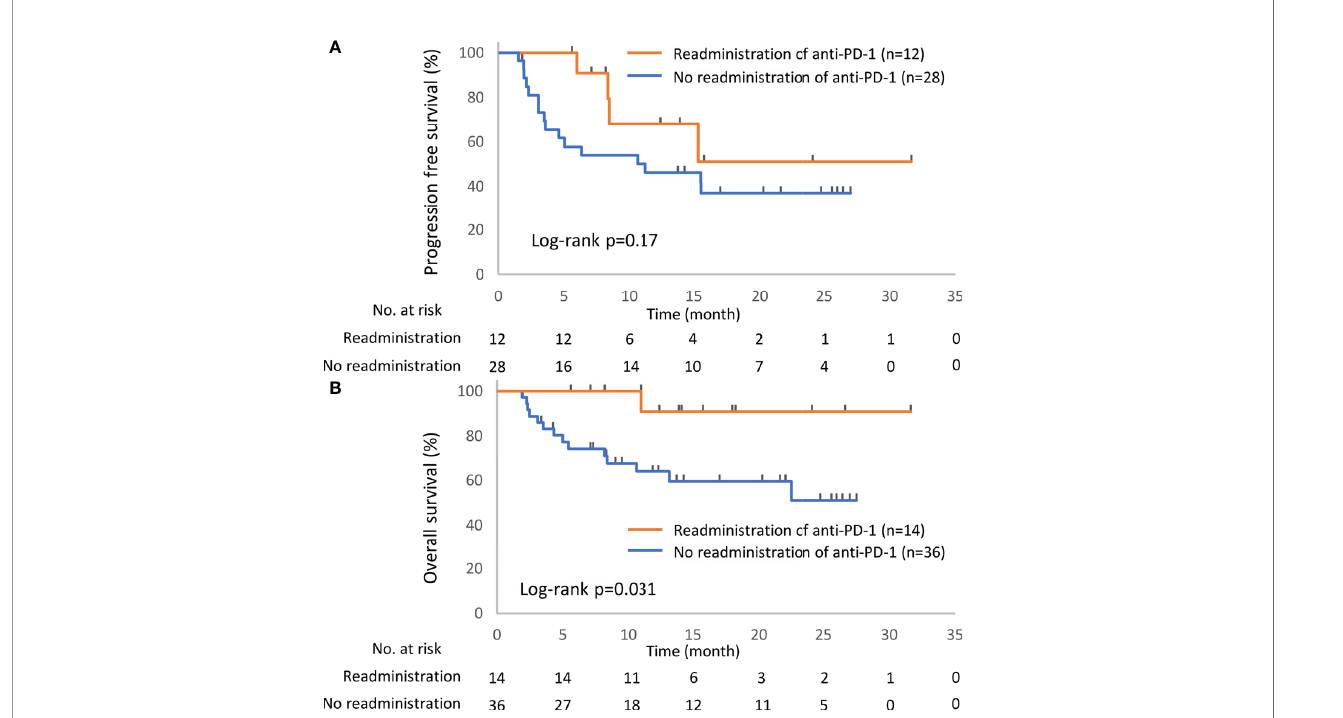
FIGURE 4 | Kaplan – Meier curves for the 6-week landmark analysis of the progression-free survival (A) and overall survival (B) of patients with or without the readministration of anti-PD-1 treatment after the discontinuation of anti-PD-1 treatment due to irAEs. PD-1, programmed cell death-1; irAE, immune-related adverse event.